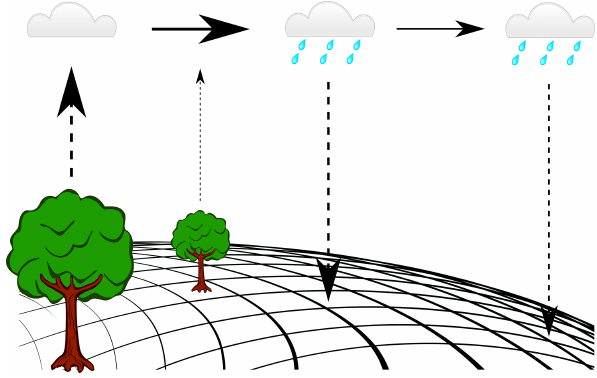
Figure 1. Moisture tracking from source to sink. All moisture- tracking models use atmospheric reanalysis data to simulate the lo- cations of moisture. At each time step, moisture budgets are updated based on wind speed and directions (horizontal arrows), evaporation (dashed arrows up), and precipitation (dashed arrows down). This leads to source-to-sink estimates of atmospheric moisture flows, such as the evaporation footprints and basin recycling ratios in this study.